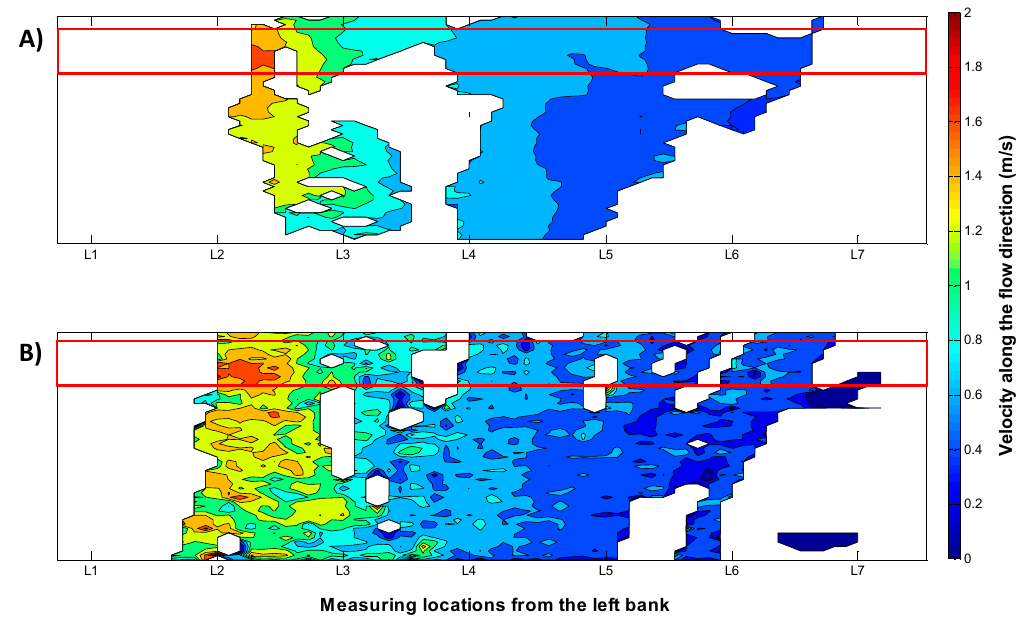
Figure 8. Examples of flow velocity maps calculated with ( A ) PTV and ( B ) LSPIV techniques for frame window FW5 on Bradano River. Red squares represent ROI considered for the analysis.